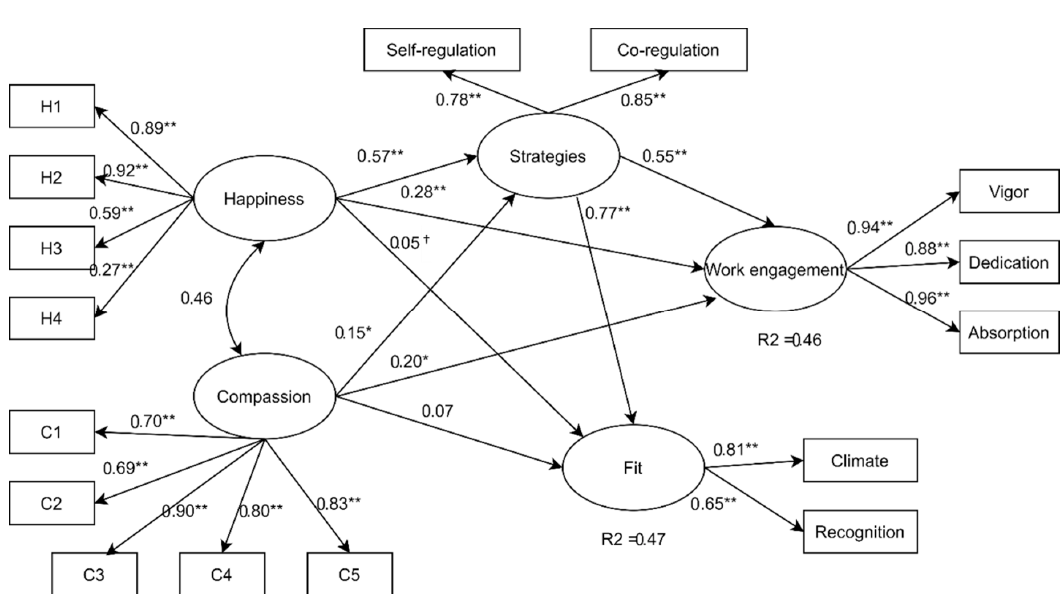
Figure 1. Results of the structural equation model. Association between happiness and compassion with teacher work engagement and fit. Happiness and compassion reported positive direct effects on the target variable with similar patterns but with different magnitudes. Note: Standardized direct effects were reported; * p < 0.05, ** p < 0.01, † not statistically significant.